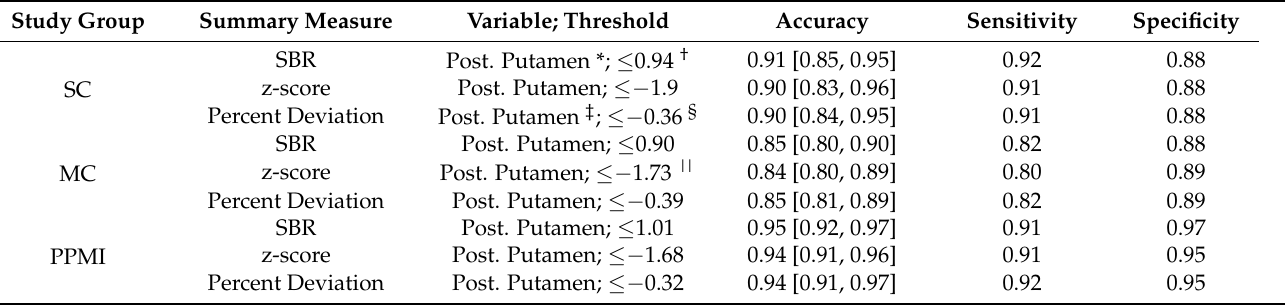
Table 2. Single Variable